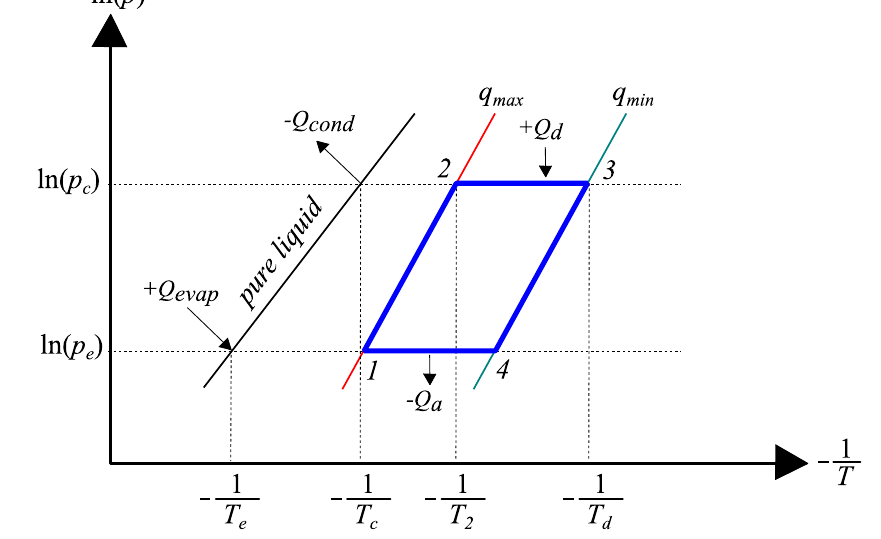
Figure 2. The Clapeyron diagram of an adsorption cycle.